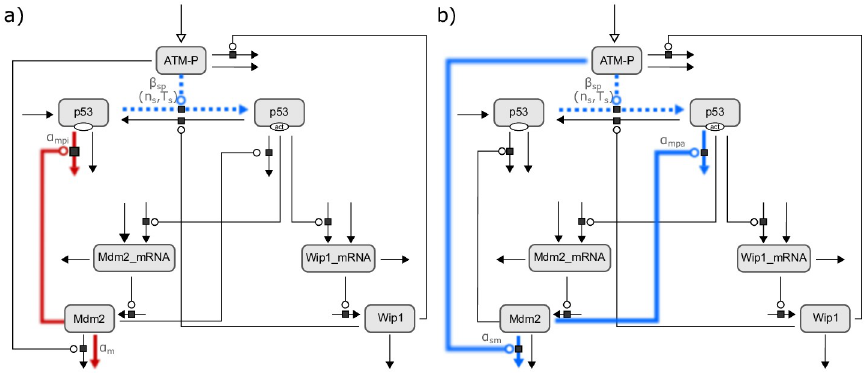
The dotted lines indicate that the parameter combinations differ in the corresponding parameters ( β sp and T s ), but the affected process is the same. In both parameter combinations the process is predicted to be reduced, which is denoted by the blue color. In contrast, the red solid lines represent the two processes shared among the two combinations, which are predicted to be increased. b) The parameter combinations α mpa & α sm & β sp and α mpa & α sm & T s constitute the second mechanism. In accordance to the first mechanism, the two parameter combinations differ in parameter β sp and T s . The two parameters affecting ATM-induced degradation of Mdm2 ( α sm ) and Mdm2-mediated degradation of activated p53 ( α mpa ) are predicted to be reduced upon IKK2